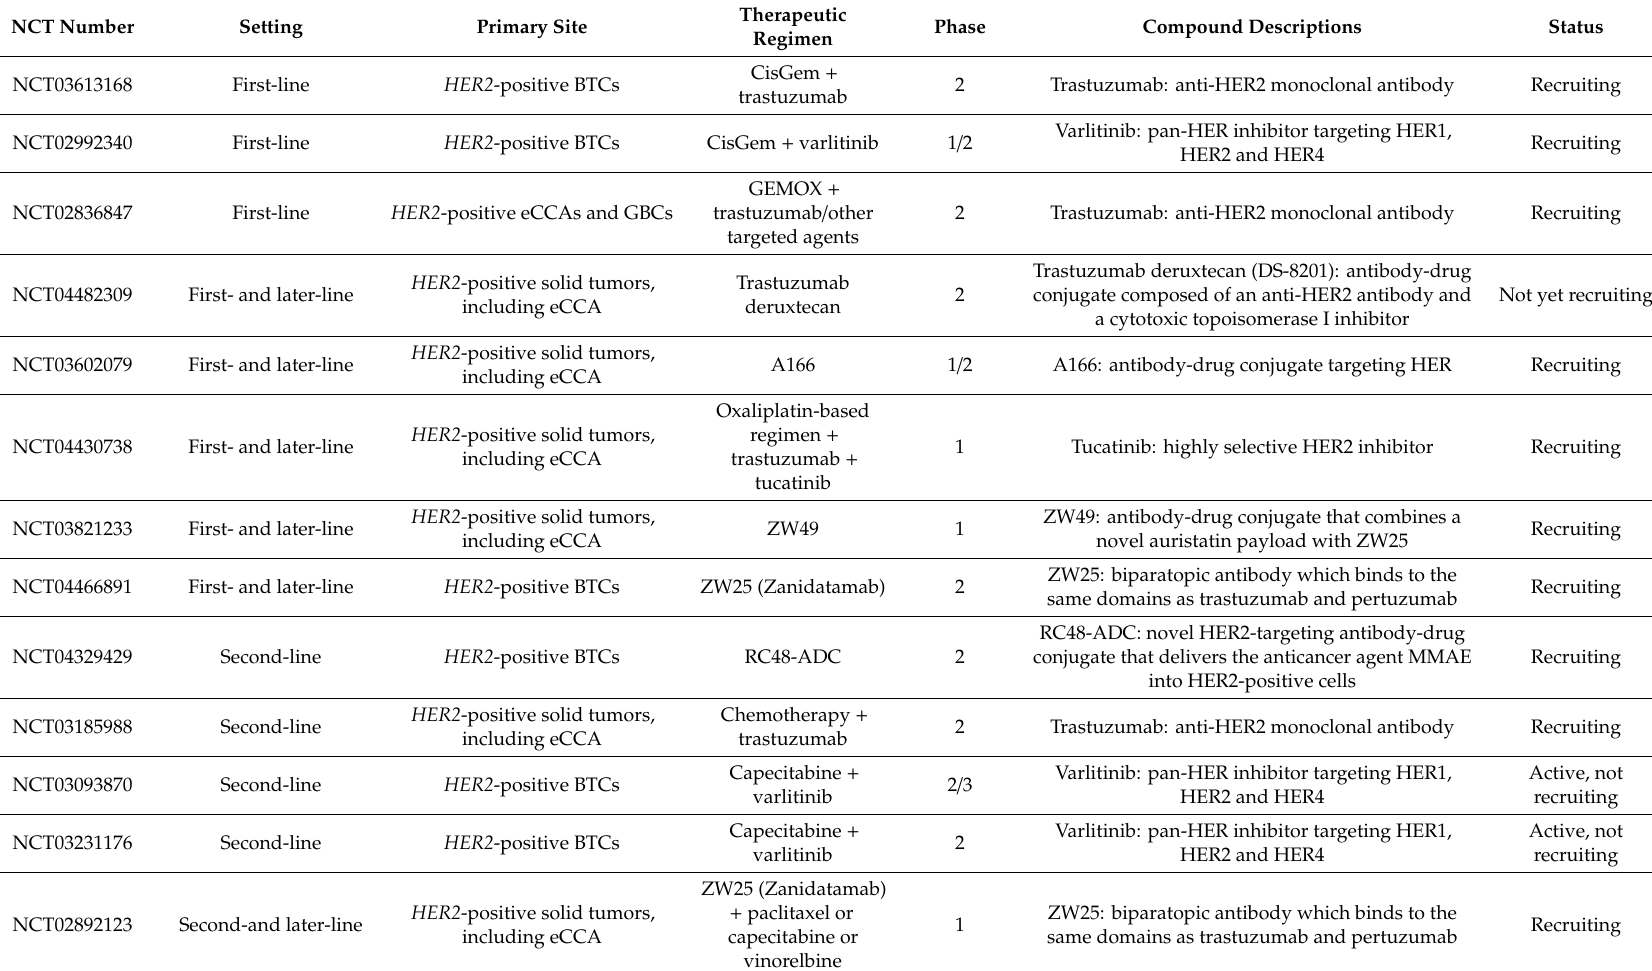
Table 1. Current ongoing trials involving HER2-targeted therapies in CCAs registered on